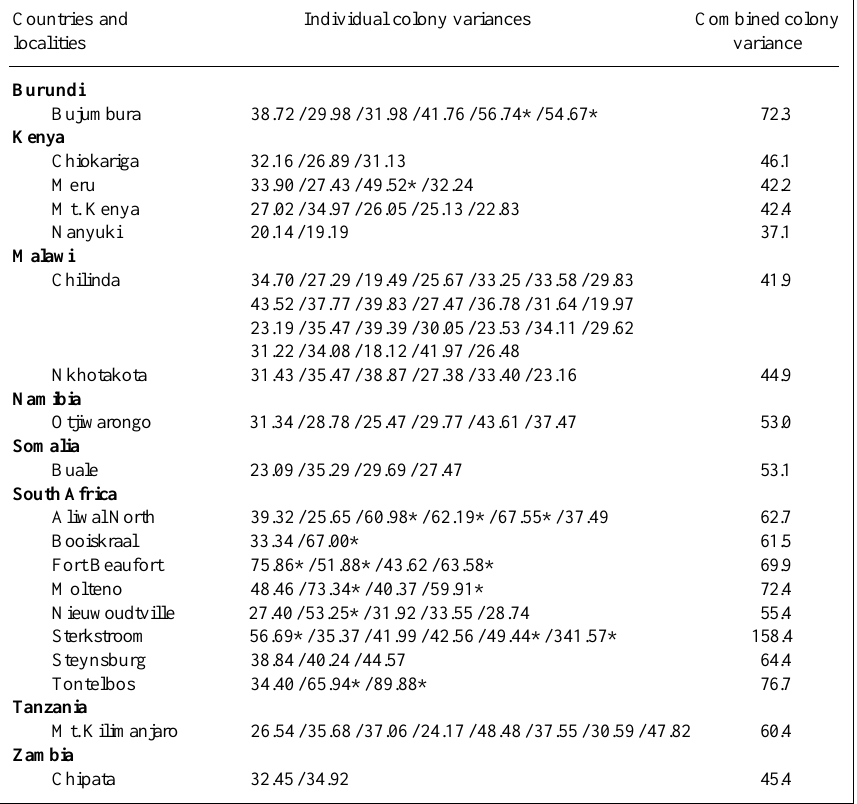
Table III - Intracolonial variances of worker honeybees at localities with high intercolonial variances. Countries and Individual colony